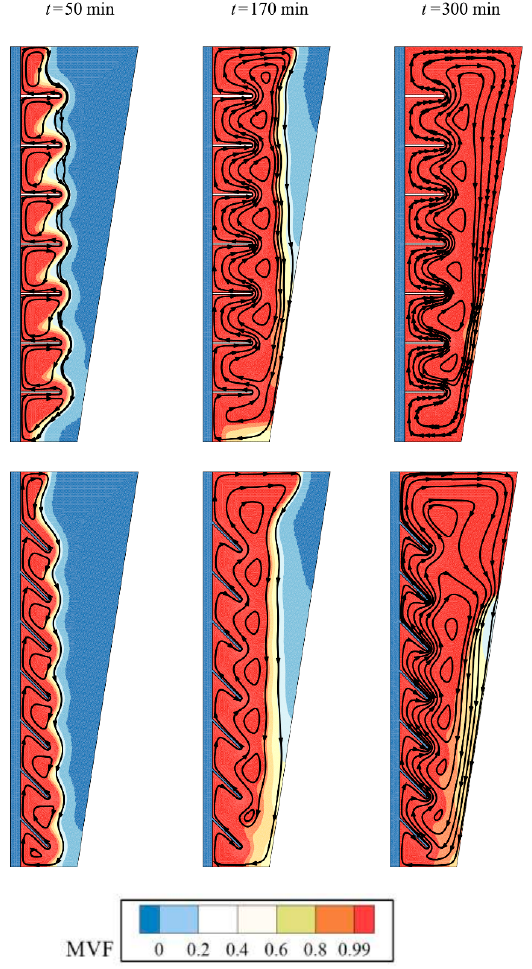
Figure 9. Effect of angle of fins (rad) ( α ) on the stremlines, (Top row) Optimum case with α = 0, and (bottom row) Case 5 with α = − 0.25 π for υ na = 0.04, and AR = 0.675.